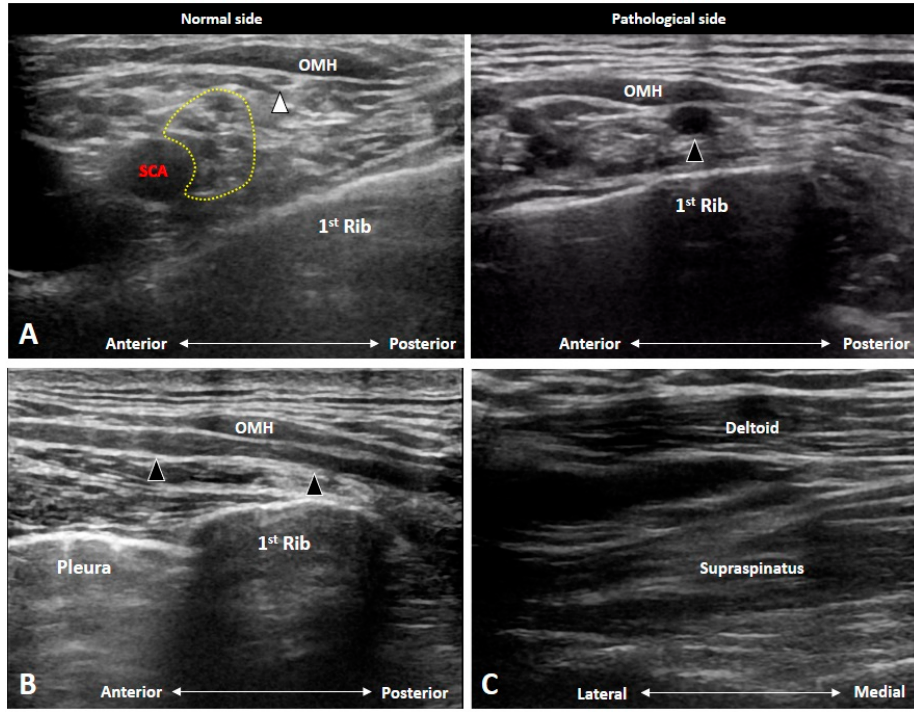
Figure 13. Ultrasound imaging of the suprascapular nerve (black arrowheads) in a patient with Parsonage-Turner syndrome ( A ). The normal nerve (white arrowhead) on the contralateral side ( A ). The enlarged suprascapular nerve in the long-axis view ( B ), atrophy and fat infiltration of the supraspinatus and infraspinatus muscles ( C ) are also seen. OMH: omohyoid muscle; SCA: subclavian artery. The yellow dashed area encircles the brachial plexus.